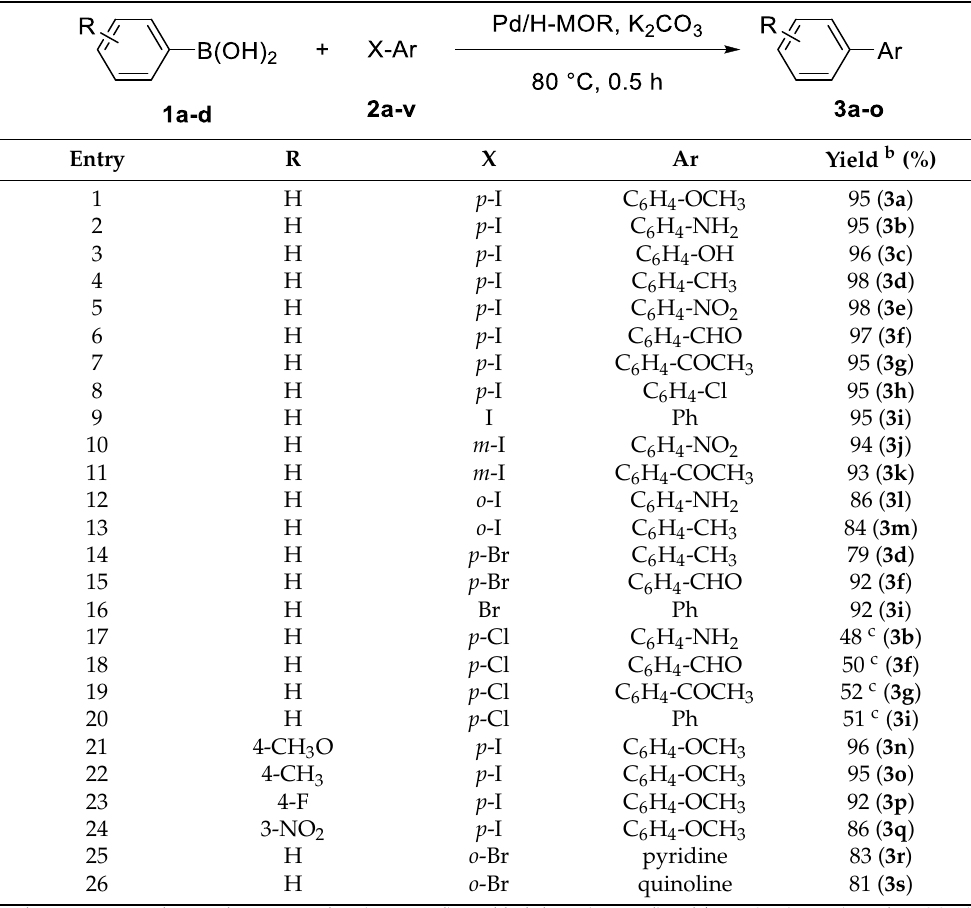
optimized reaction conditions, producing the corresponding products (Table 3, entries 25,26). Table 3. Suzuki coupling between phenylboronic acid and aryl halides. Table 3. Suzuki coupling between phenylboronic acid and aryl halides a .